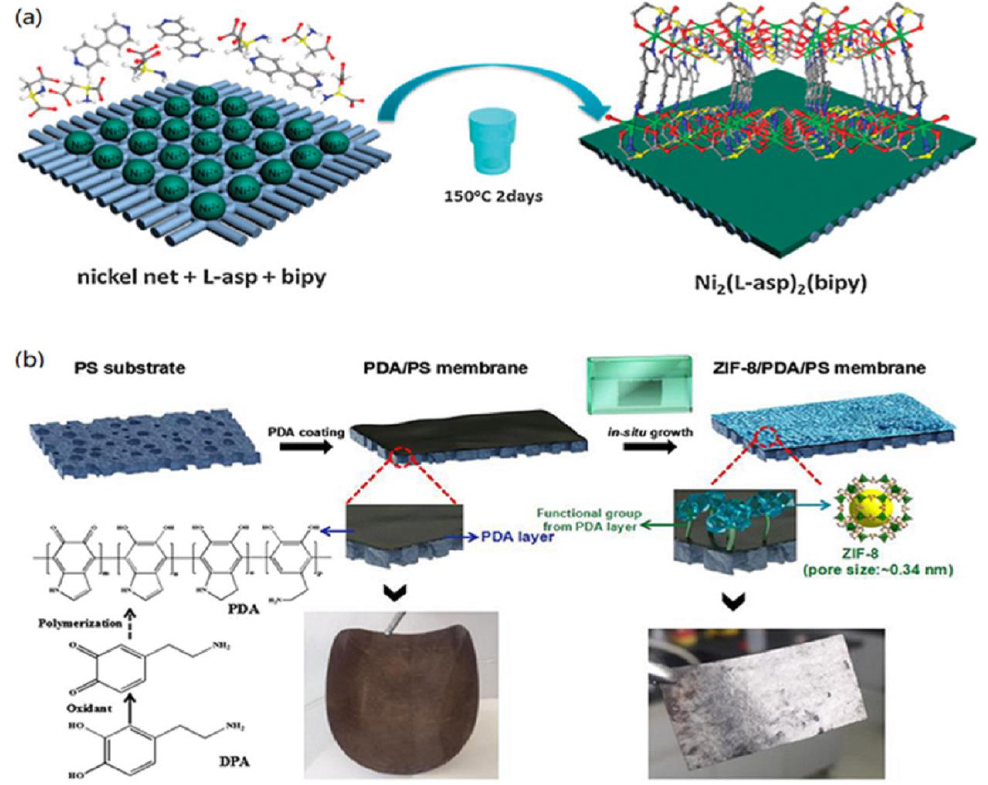
Figure 1. Schematic illustrations of the in-situ synthesis of continuous MOF membranes: ( a ) the growth of Ni 2 (L-asp) 2 (bipy) on an unmodified nickel support and ( b ) the growth of ZIF-8 membrane on a modified PS support. Reprinted with permission from Refs. [12,40].